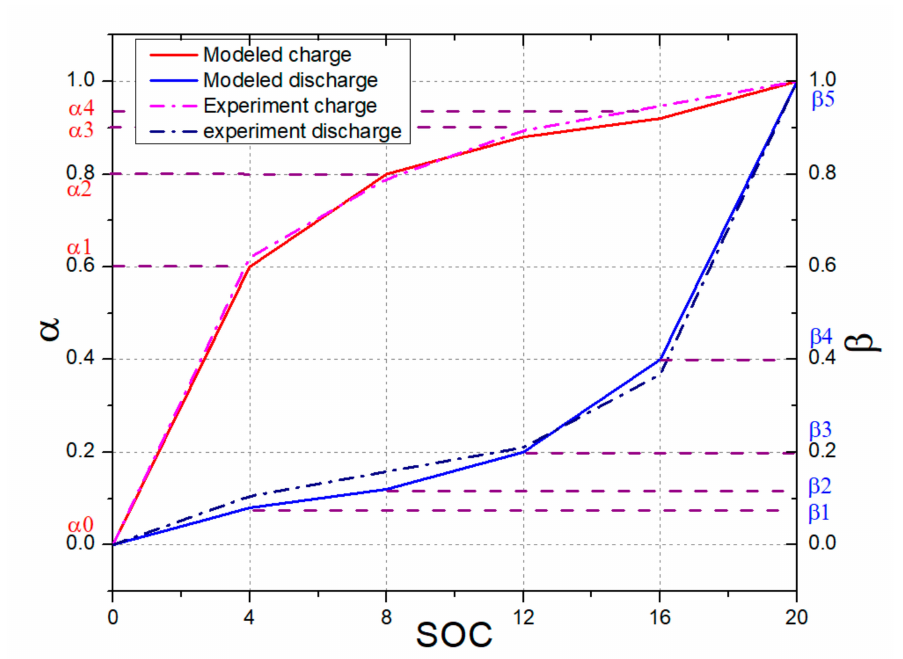
Figure 4. Proposed modeling method for the minor loop